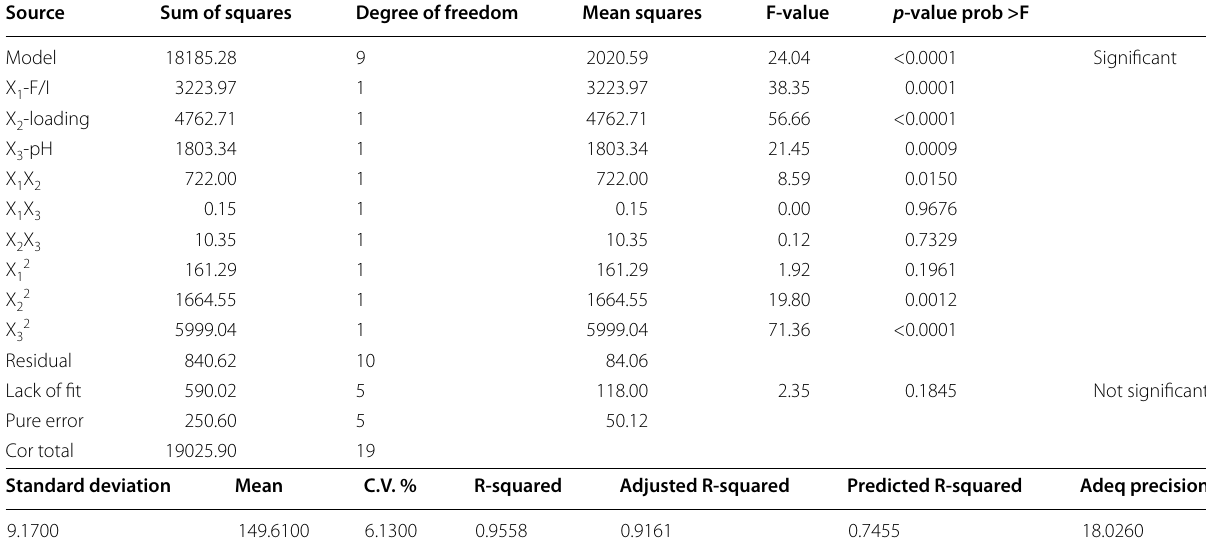
C.V. % coefficient of variation